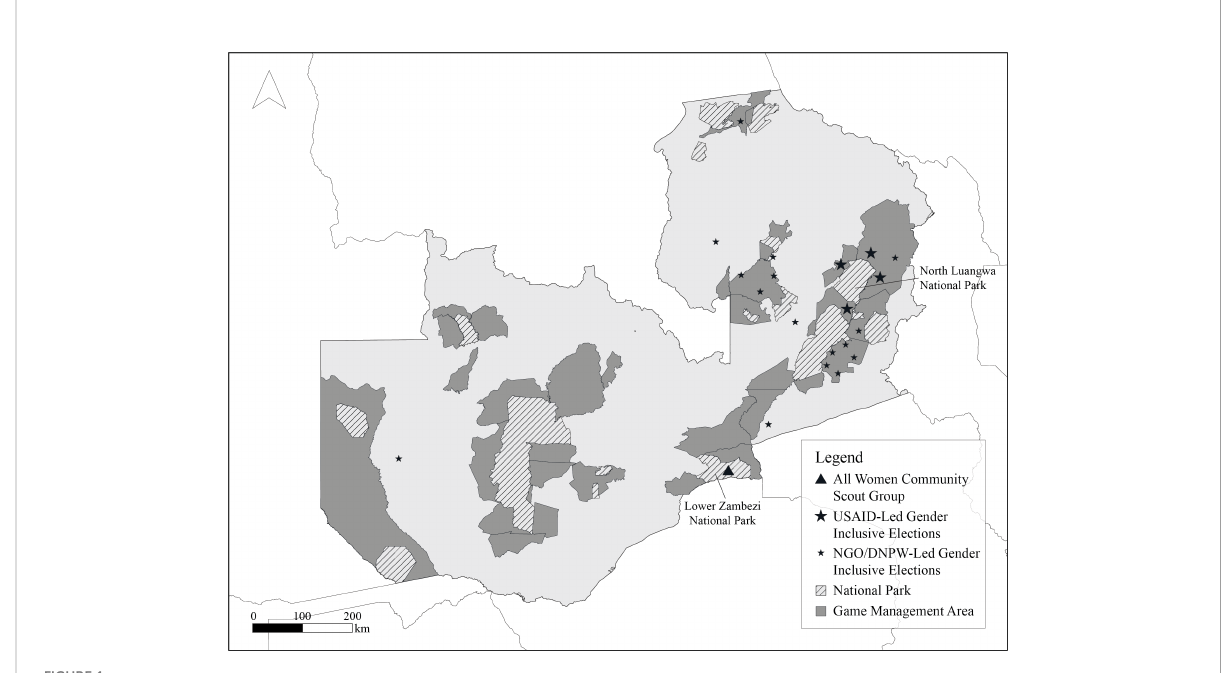
FIGURE 1 Map of protected areas in